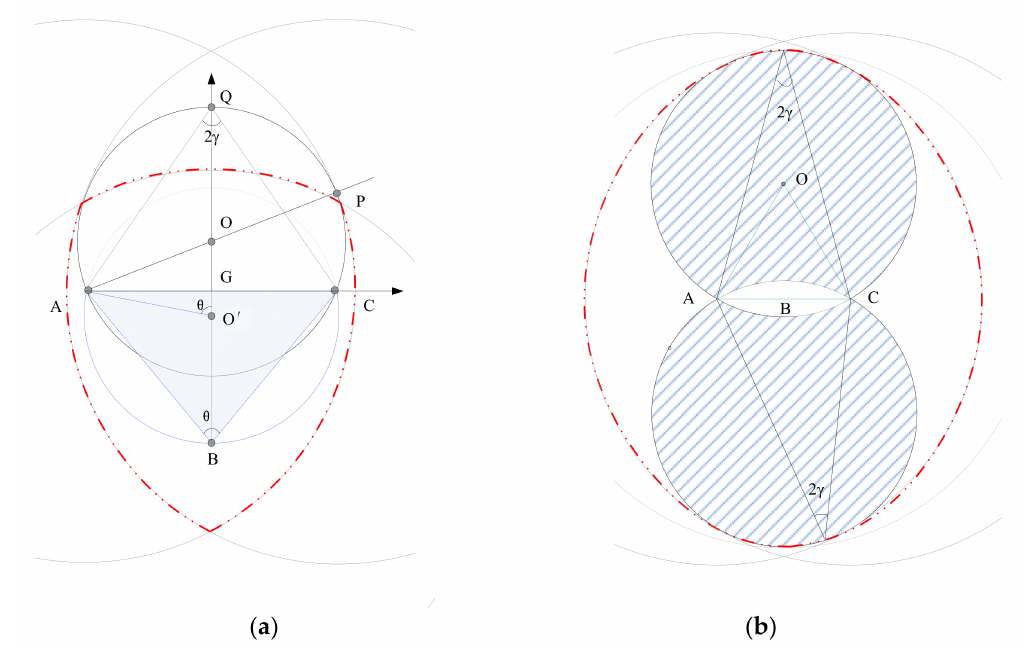
Figure 4. Design of range of time difference localization. ( a ) Equilateral triangle layout by A, B, C; ( b ) Line layout by A, B,